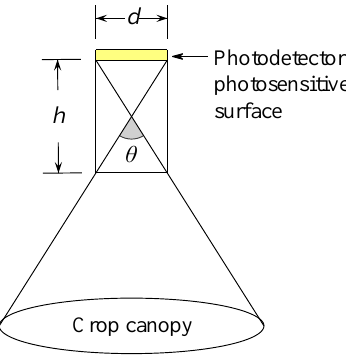
Figure 3. Schematic diagram of the sensor field of view.